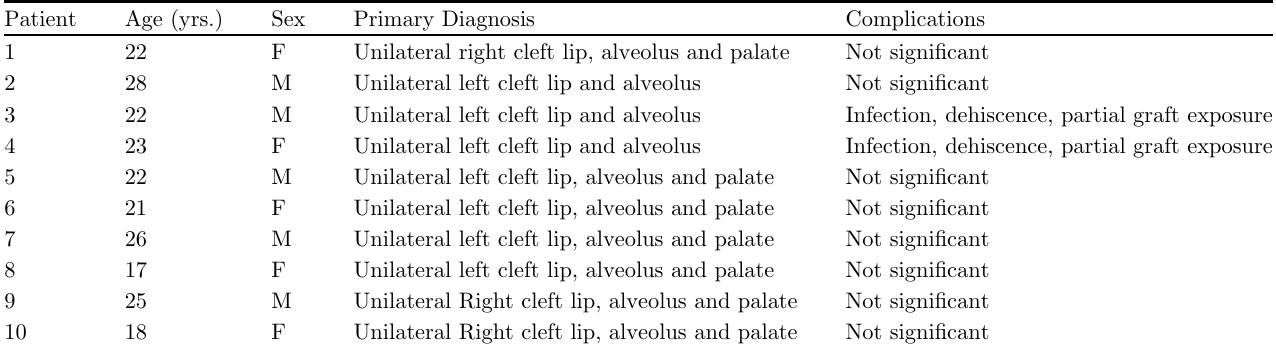
Table 3. Patient data treated with mineralized plasmatic matrix (anterior iliac bone grafting with PRP and PRF. Patient Age